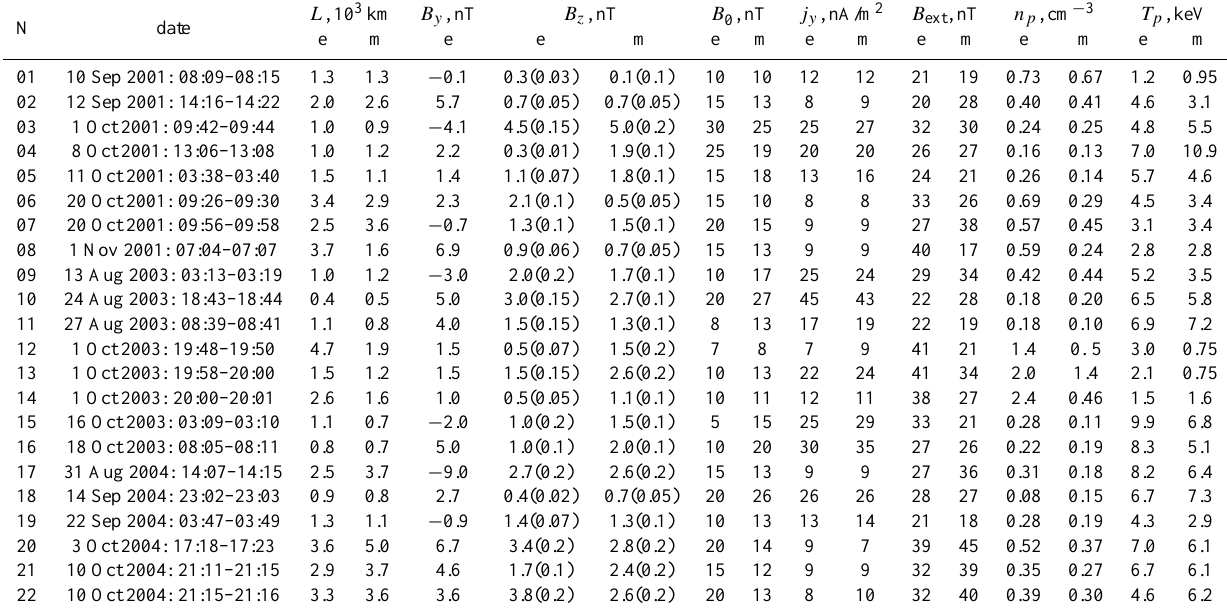
Table 1. Parameters of experimental (e) and model (m) sheets.